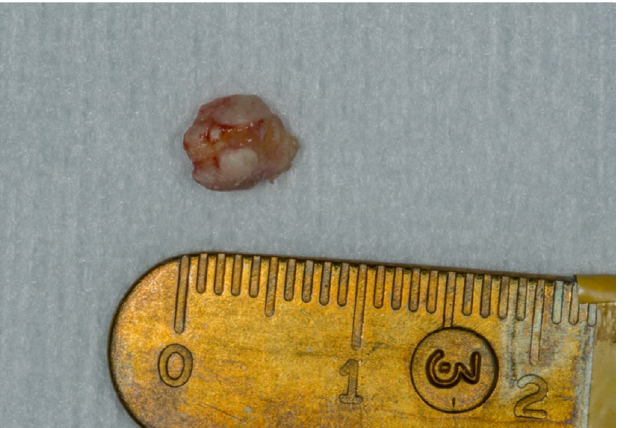
Fig. 6. Bimanual palpation of the mouth fl